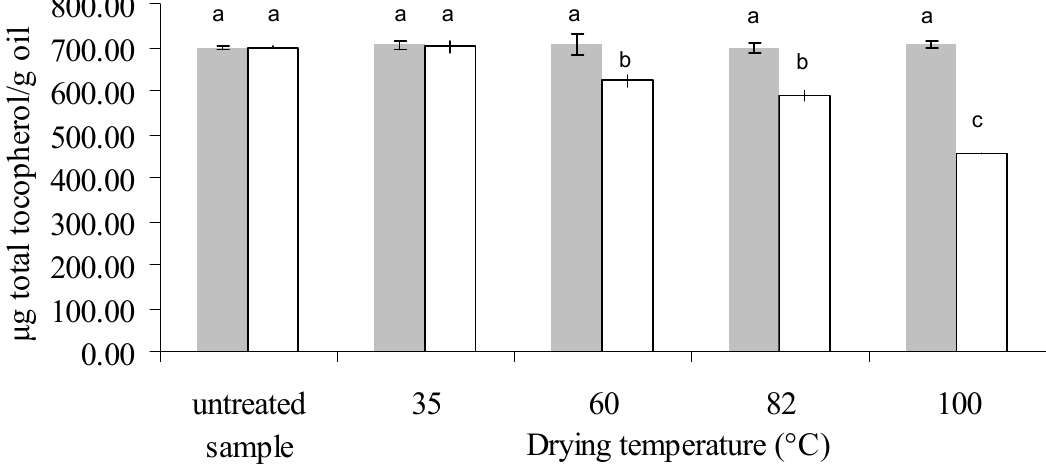
Figure 2. Total tocopherol concentration in the oil extracted from untreated and treated samples of canola, at an initial moisture level of 13.6% db ( ■ ) and 22.7% db ( □ ) and final moisture content of 7% db in all treated samples. Different letters indicate significant differences (Tukey’s test, p < 0.05). Eight independent drying experiments. n (number of replicates of each measurement): 2.